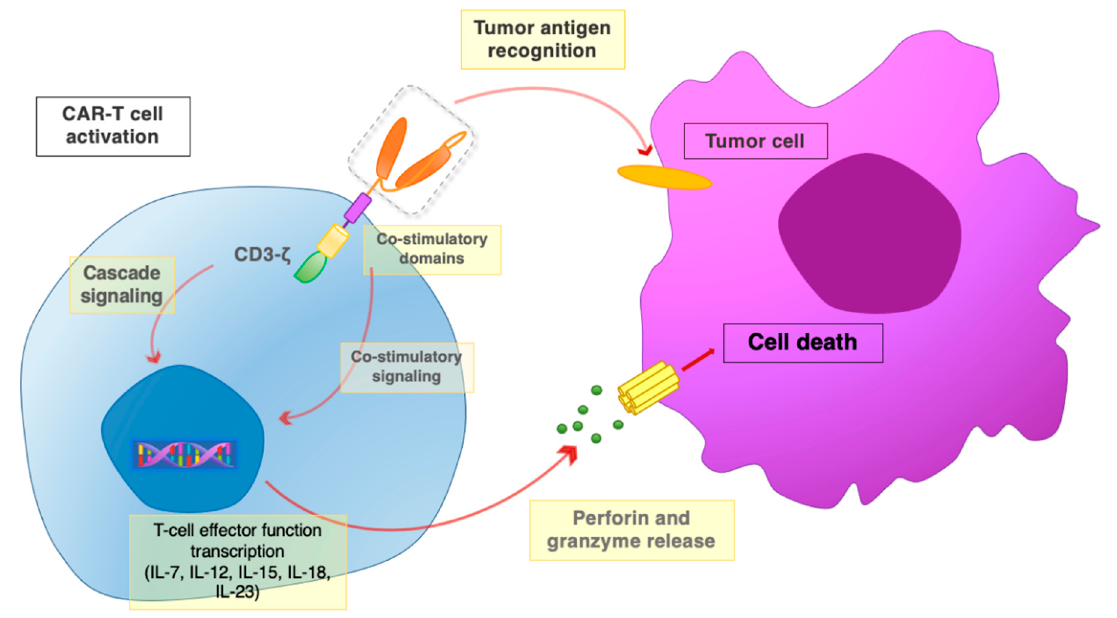
Figure 4. The CAR-T interaction with tumor cells. Once the scFv portion recognizes and binds the tumor antigen, the co-stimulatory domains and the CD3 ζ chain promote activatory signaling cascades. Downstream signaling leads to the activation of T cell effector functions, with the release of perforin and granzyme, leading to the death of target tumor cells.